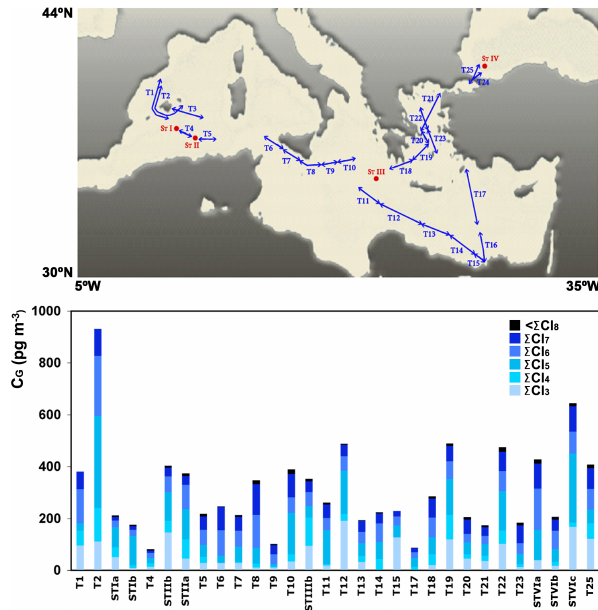
Figure 1. Location of the atmospheric samples and spatial distribu- tion of gas-phase concentrations of PCBs (pgm − 3 )